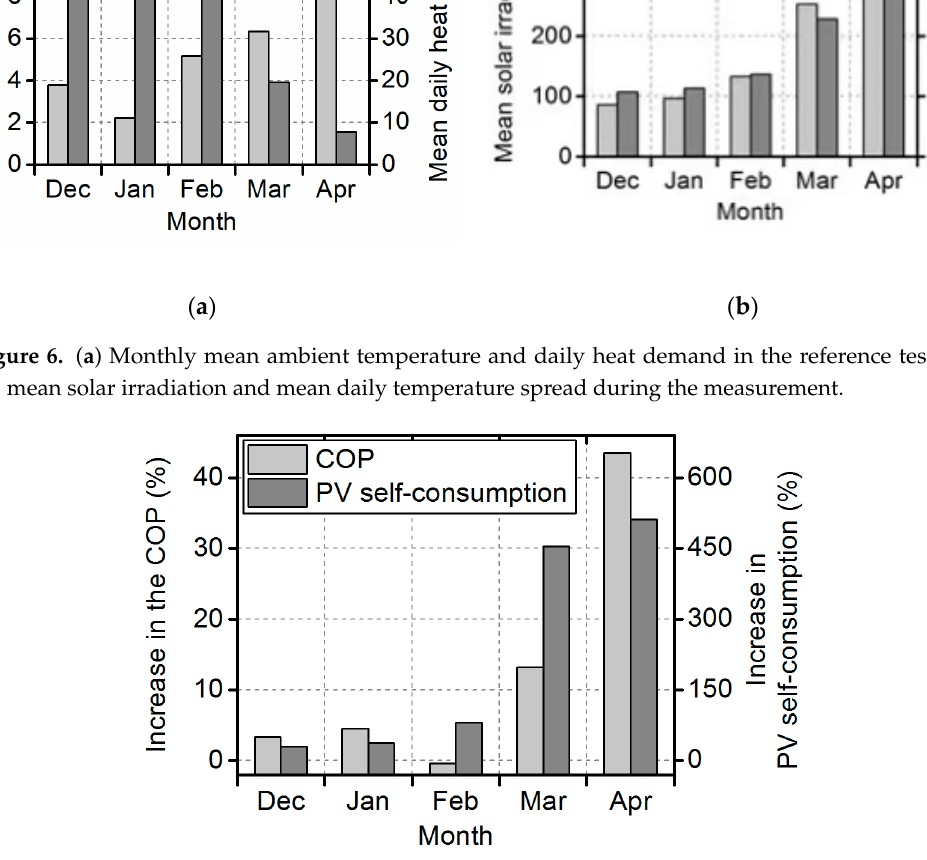
Figure 7. Monthly increase in the heat pump coefficient of performance (COP) and the heat pump self-consumption of photovoltaics (PV) electricity by application of model predictive control (MPC) in the long-term experiment.